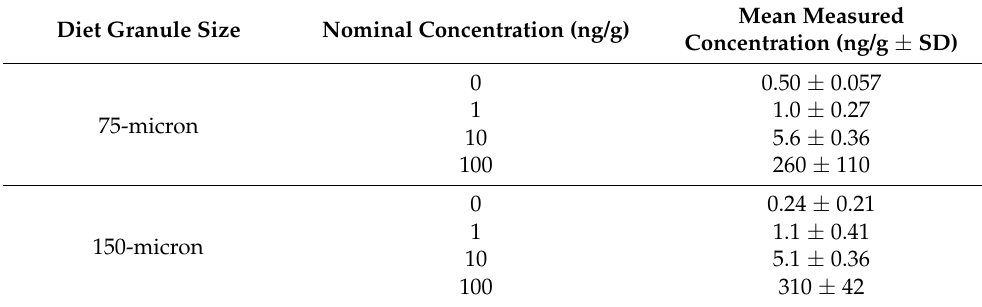
Table 1. Measured PFHxA concentrations in zebrafish